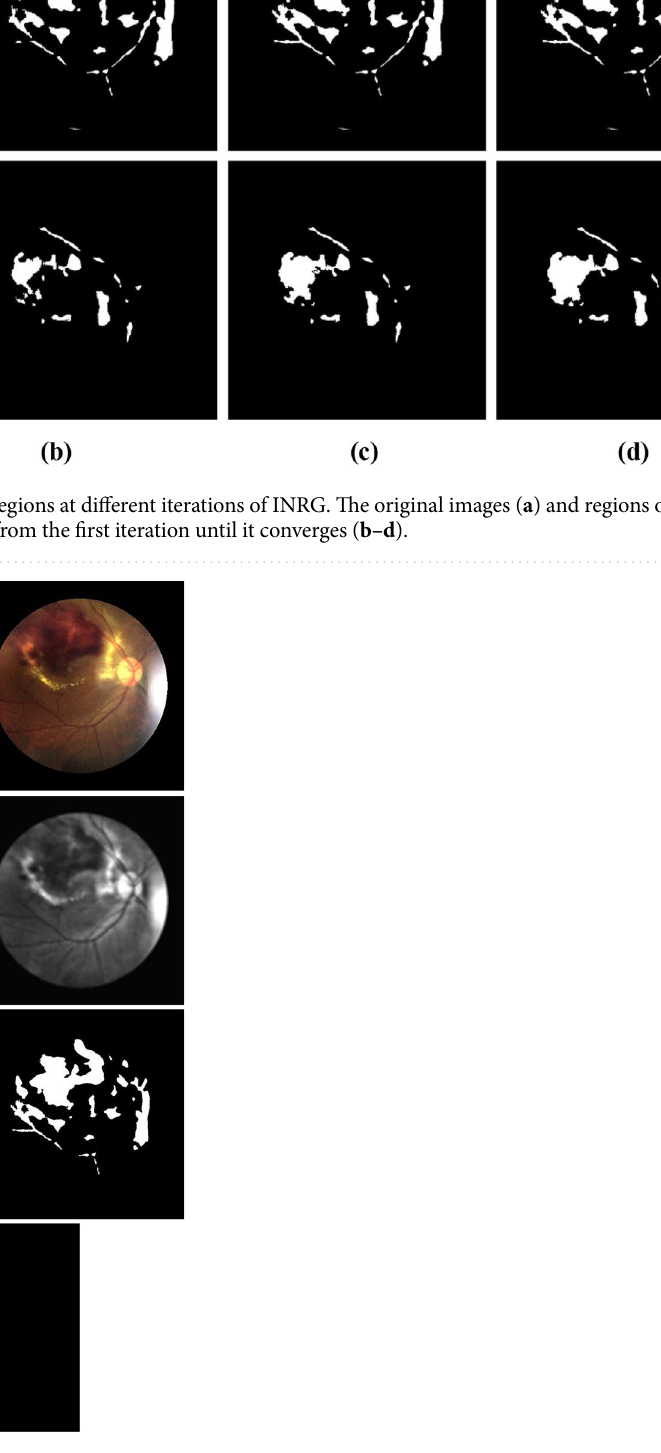
Figure 3. Illustration of overall processes to obtain hemorrhage: original image (top left), after applying KMMRC to adjust local contrast (top right), after conversion to a grayscale of the green channel and global contrast enhancement using CLAHE (second row-left), after noise filtering using average filter (second row- right), after region segmentation using INRG algorithm (third row-left), after vessel removal (third row-right), and after classification